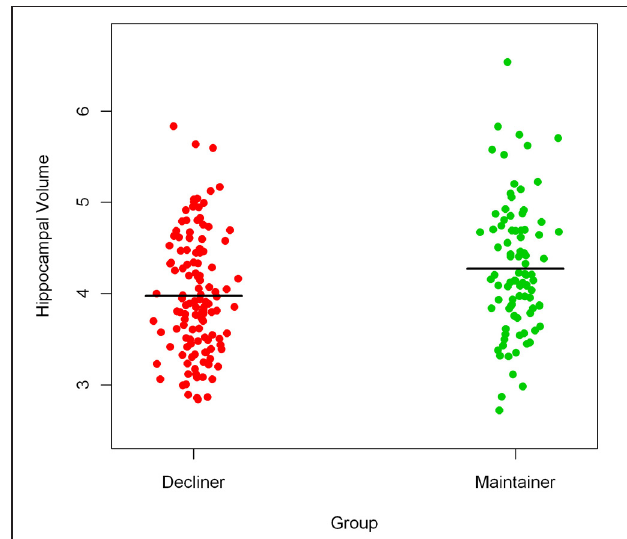
FIGURE 3 | Mean difference in hippocampal volume between cognitive decliners and cognitive maintainers.